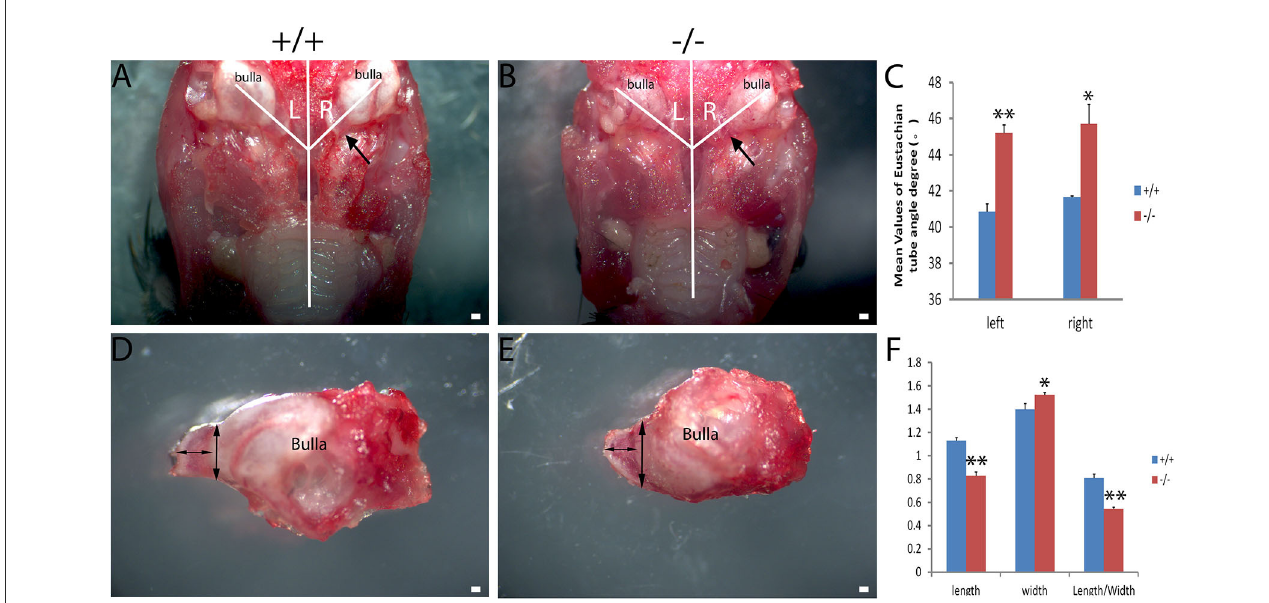
FIGURE4 Assessment of the Eustachian tube’s dysmorphology in Galnt2 tm1Lat / tm1Lat mice. Wild-type ( + / + ) and mutant mice (-/-) at the age of 2 months ( n = 6 for each genotype, equal numbers of male and female mice were selected) were used to measure the intersection angle between the midline and the Eustachian tube (A, B) and the length and width of the bony part of the Eustachian tube (D, E) . (C) The intersection angle is significantly larger in mutant mice, compared with the wild-type mice. Wild-type and mutant mice were used to measure the length and width of the bony part of the Eustachian tube (D, E) . (F) The mean length of the Eustachian tube in wild-type mice is longer than that of the mutant mice, whereas the mean width of the Eustachian tube in mutant mice is wider compared with the wild-type mice. The length/width ratio in wild-type mice is greater than that of the mutant mice. The arrow shows the location of the Eustachian tube. The double-ended arrow shows the length and width of the bony part of the Eustachian tube. The error bar represents the standard error (SE) of the mean. * P < 0.05, ** P < 0.01. Scale bar = 200 µ